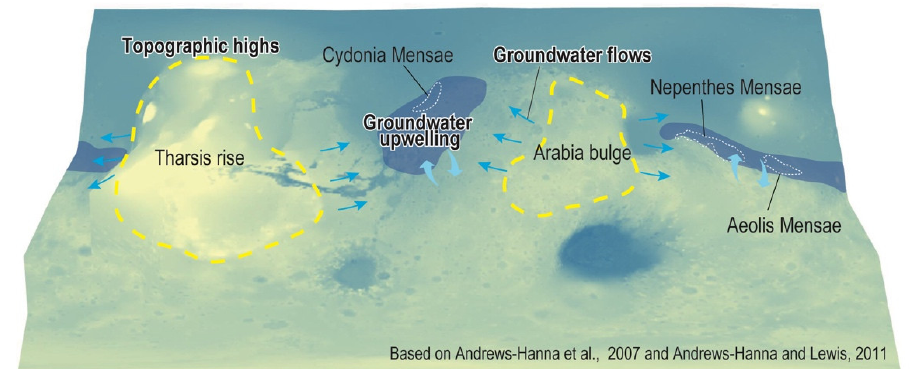
Figure 13. Schematic illustration of global groundwater flows on Hesperian Mars, based on Andrews– Hanna et al. [66,71]. Groundwater is considered to have flowed from the southern highlands to the northern lowlands (cyan bold arrows). Groundwater would have upwelled at local steep slopes and impact craters at the dichotomy boundary. Owing to the rise of Tharsis and the antipodal topographic highs of the Arabia bulge (yellow dashed lines), groundwater flows would have been concentrated around the regions (Aeolis Mensae, Cydonia Mensae, and Nepenthes Mensae) between them (blue arrows). Blueish hatched areas represent regions where groundwater could have been concentrated.